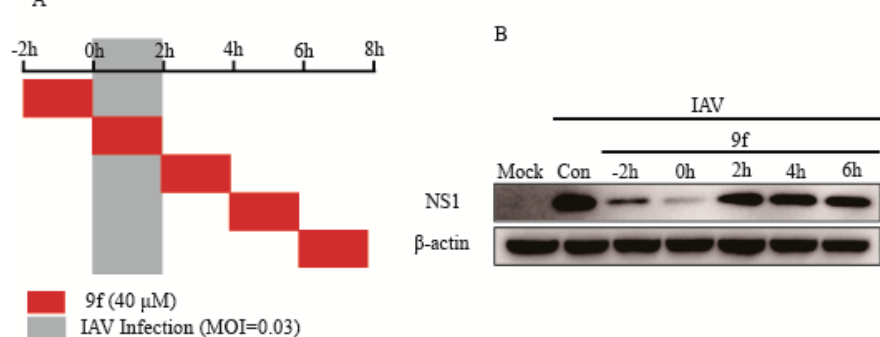
Figure 4. Compound 9f inhibited the influenza virus replication cycle at an early stage according to the time-of-addition study. ( A ) Schematic of the experiment to determine which stage of the viral cycle is inhibited by compound 9f in MDCK cells. ( B ) MDCK cells infected with IAV (H3N2, MOI = 0.03) were treated with compound 9f (40 μ M) either at − 2 h, 0, 2, 4 or 6 h p.i., and virus NS1 expression were detected by Western blot at 8